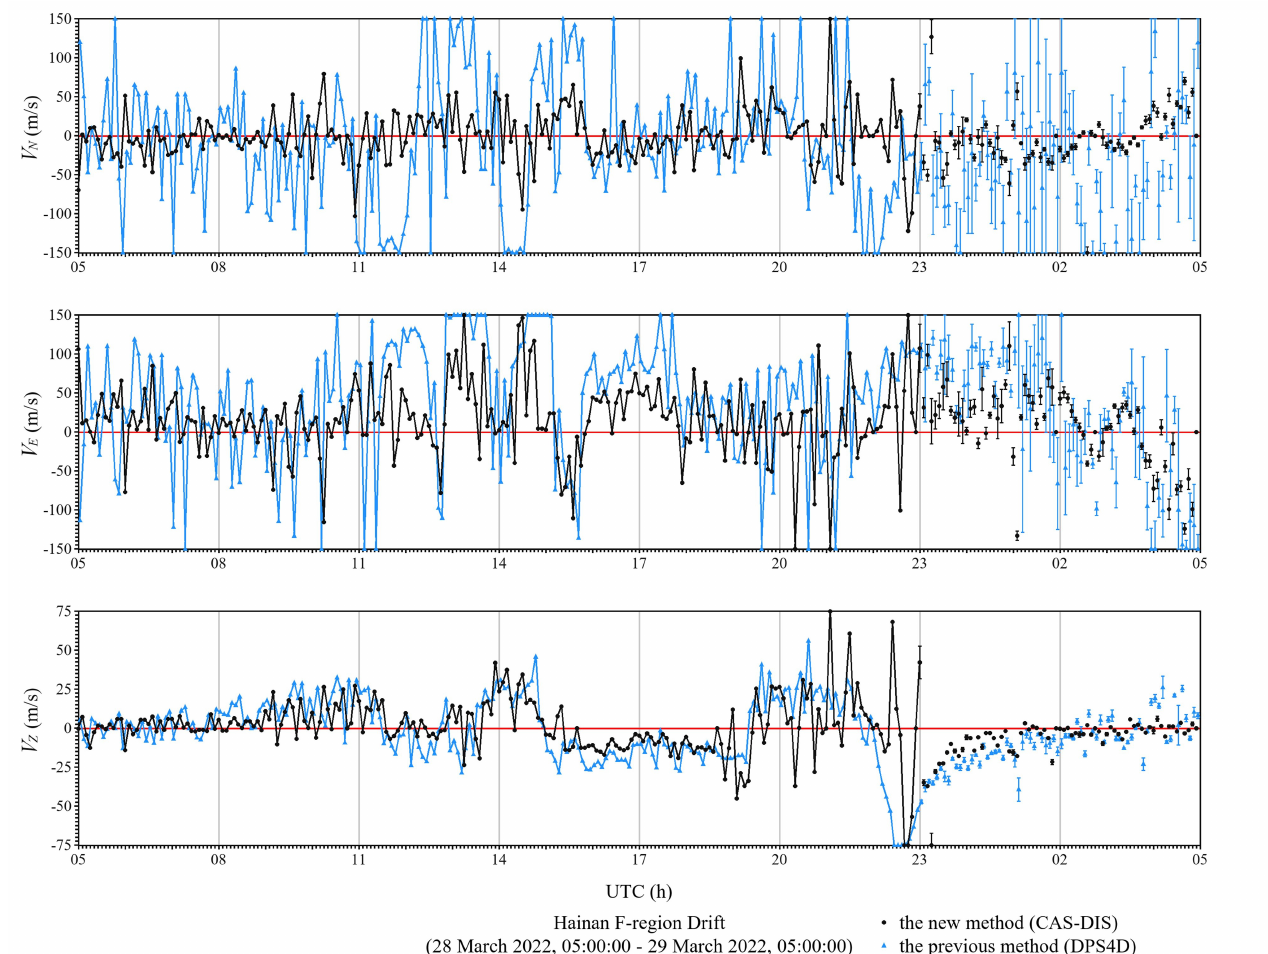
Figure 11. Statistics of the F-region drift velocity in Hainan from 28 March 2022, 05:00:00 to 29 March 2022, 05:00:00 in